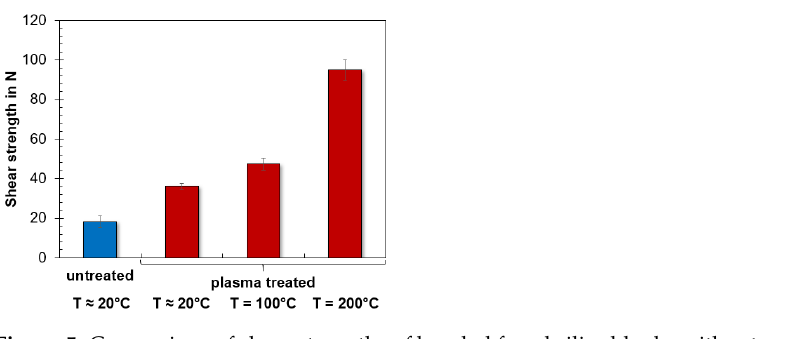
Figure 5. Comparison of shear strengths of bonded fused silica blanks without any plasma treatment (untreated) and after plasma treatment for 30 s and curing at different annealing temperatures.